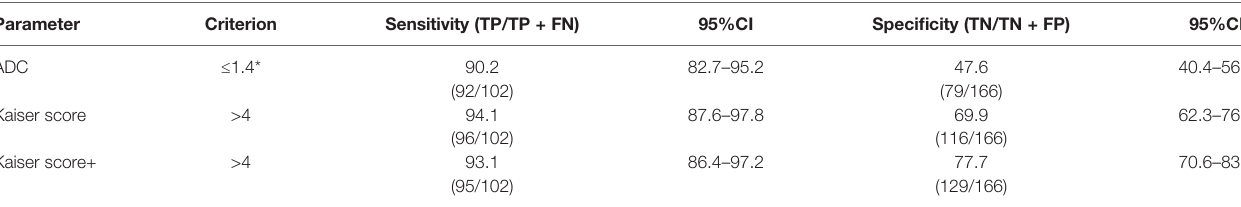
TABLE 5 | Sensitivity and speci fi city for three